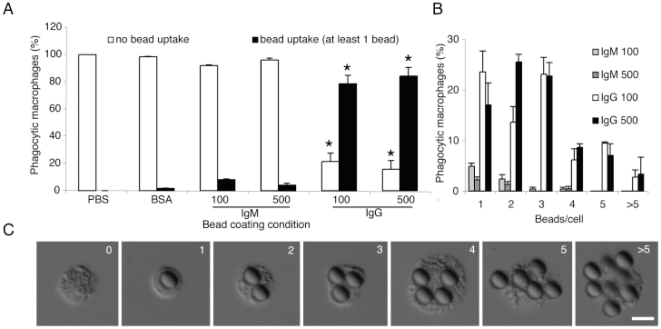
Human IgG, but not IgM, drastically enhances uptake of large beads by macrophages.(A) Macrophages effectively bind and internalize IgG-coated, but not IgM-, BSA-, or PBS-coated, large beads (∼8.31 µm; p<0.05). (B) Counting numbers of “beads/cell” shows that IgG-coated beads are taken up in greater quantities. Only a small number of cells binds or internalize IgM-coated beads. Bead uptake saturates at 100–500 µg/ml IgG-coating concentrations. Percentage values for each IgG and IgM condition will add up to the corresponding values shown in panel A. (C) Differential interference contrast (DIC) images show examples of IgG-coated 8.31 µm large beads that associate with or are engulfed by macrophages. A similar effect was not seen with IgM-, or BSA- or PBS-coated beads. Scale bar is 10 µm.